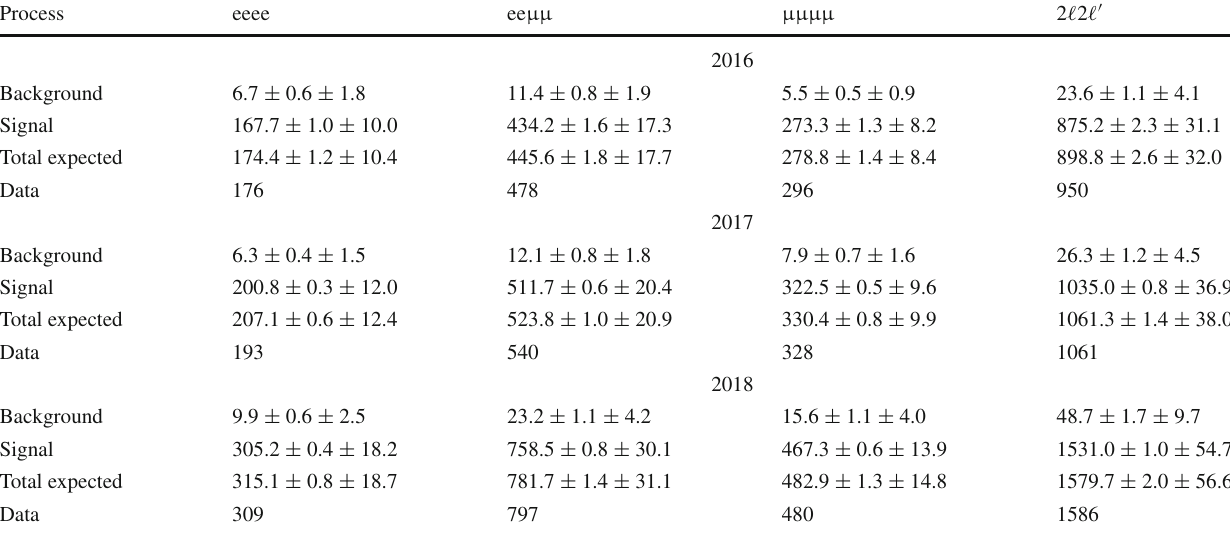
Table 2 Observed and expected prefit yields of ZZ events, and estimated yields of background events, shown for each final state and combined. The statistical (first) and systematic (second) uncertainties are presented